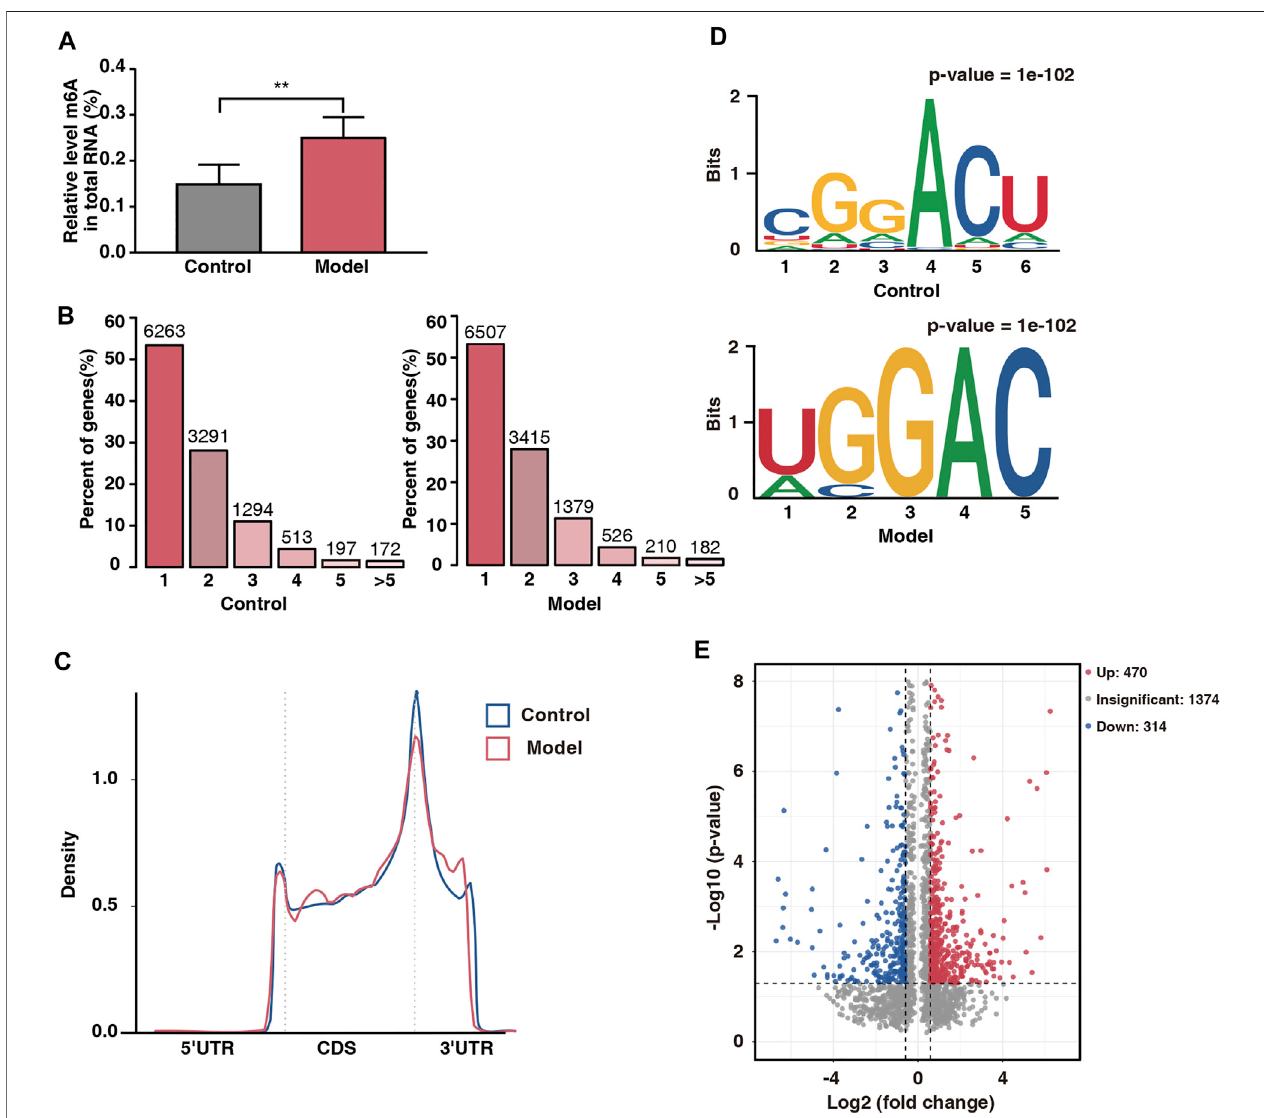
FIGURE 4 | Overview of placental m6A methylation in fear stress during pregnancy. (A) m6A modi fi cation levels of total RNA in control and model groups ( n * = 6, ** p < 0.01). (B) Numberofpeaksofm6A-modi fi edgenesincontrolandmodelgroups.Sequencemotifswithm6Apeakregionsincontrolandmodelgroups. (C) Density ofdifferentialm6Apeaksalongtranscripts. (D) Sequencemotifswithm6Apeakregionsincontrolandmodelgroups. (E) Distributionofdifferentiallymodi fi edm6Apeaks in control and model groups (fold change ≥ 1.5 and p < 0.05).